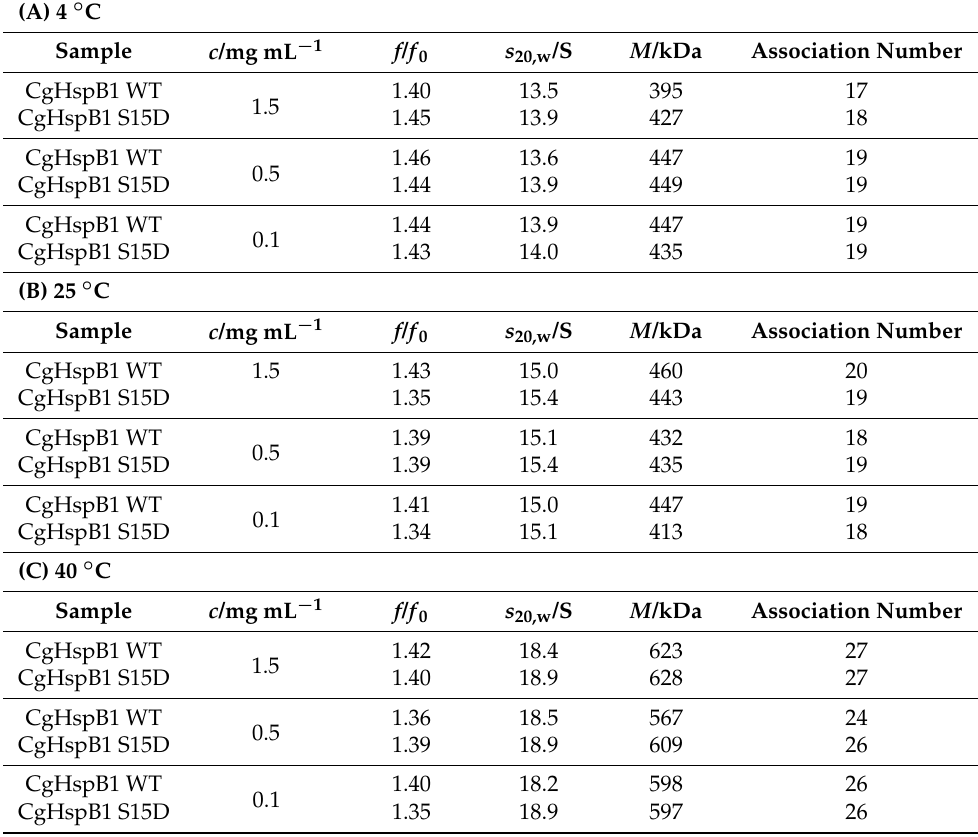
Table 2. Parameters of main peak of c ( s 20,w ) in Figure